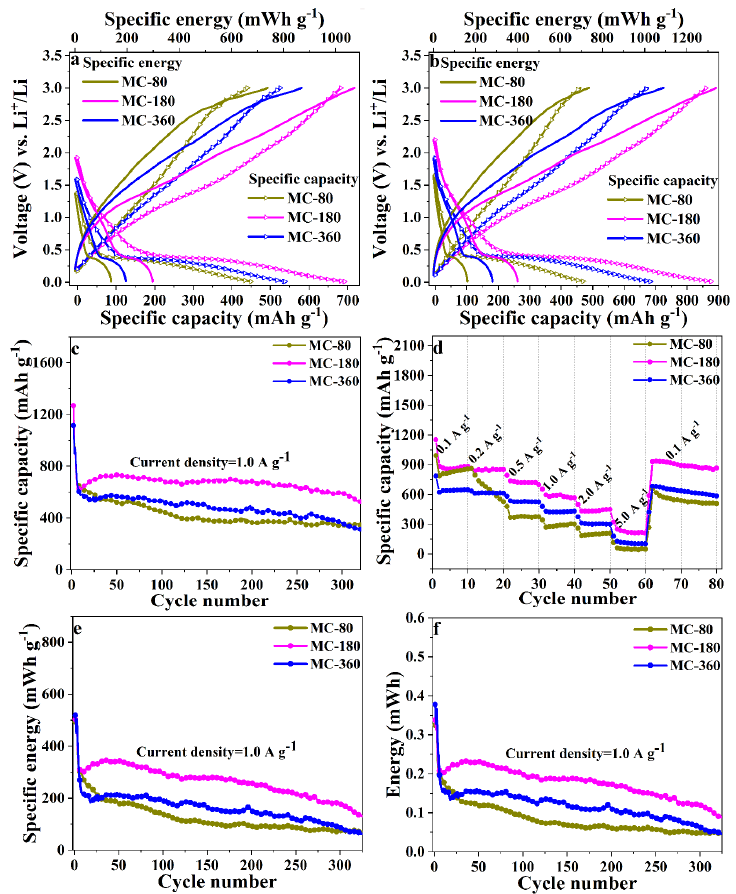
Figure 6. The charge-discharge voltage profiles at the current density of 1.0 A g − 1 ( a ) and 0.5 A g − 1 ( b ) for the 100th cycle. Cycle performance ( c ) at the current density 1.0 A g − 1 , and the rate performance ( d ) of MC-80, MC-180, and MC-360. The specific energy ( e ) and absolute energy ( f ) of MC-80, MC-180, and MC-360 at the current density of 1.0 A g − 1 .